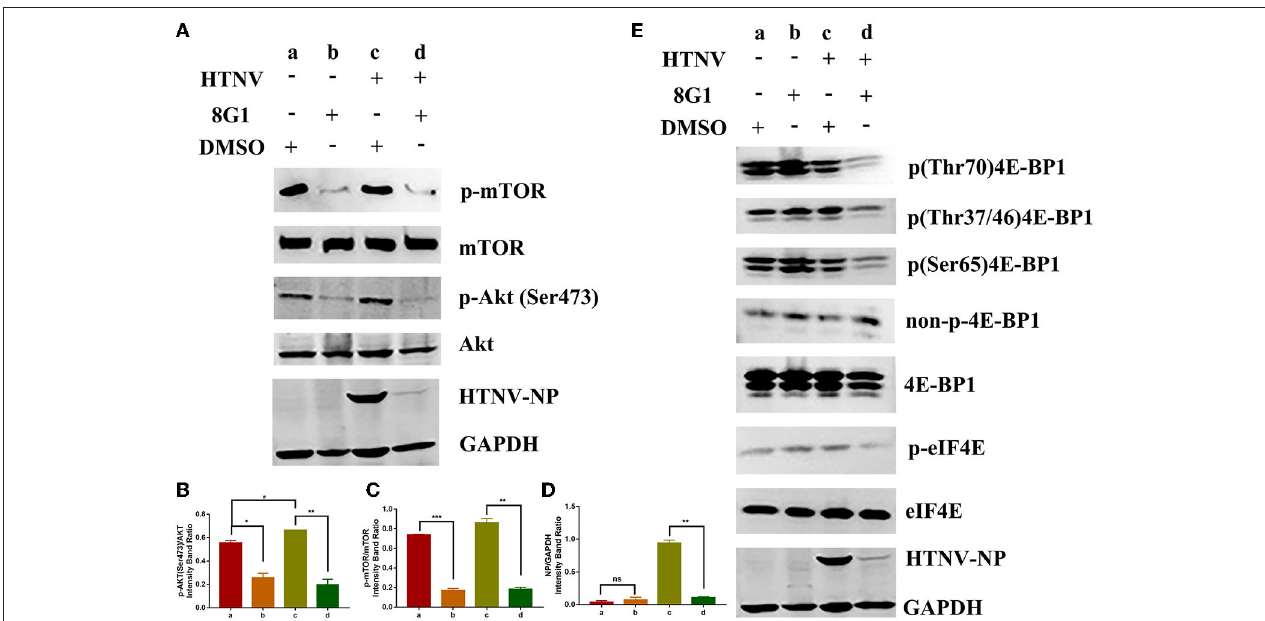
FIGURE 7 | Effect of compound 8G1 to the protein kinase B (Akt)/mammalian target of rapamycin (mTOR) pathway. (A) The representative Western blot staining for phosphorylation of Akt and mTOR proteins in A549 cells. (B) The analyzed result of the expression of p(Ser473) Akt, * p < 0.05, # p < 0.05 vs. DMSO treated group, ** p < 0.01 vs. HTNV group, n = 3. (C) The analyzed result of the expression of p-mTOR, ** p < 0.01 vs. DMSO treated group, *** p < 0.005 vs. HTNV group, n = 3. (D) The analyzed result of the expression of HTNV-NP, ** p < 0.001 vs. HTNV group, n = 3. (E) A549 cells were with treated 10 µ M 8G1 or DMSO infected in the presence of inhibitors for 96h before cells were harvested. The phosphorylation status of 4E-BP1 and elF4E was analyzed using antibodies against total 4E-BP1, p-4E-BP1 (Thr70), p-4E-BP1 (Ser65), p-4E-BP1 (Thr37/46), non-p-4E-BP1 (Thr46), p-eIF4E, and eIF4E. Total protein was isolated and analyzed by the Western blot using antibodies as shown. a A549 cells treated with solvent DMSO in the absence of HTNV infection; b A549 cells treated with compound 8G1 in the absence of HTNV infection; c A549 cells treated with the solvent DMSO in the context of HTNV infection; d A549 cells treated with compound 8G1 in the context of HTNV